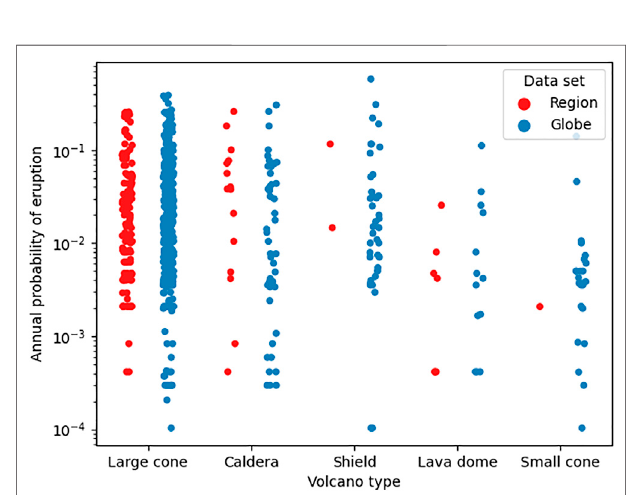
FIGURE 12 | Comparison of dispersion within the A1 volcano classi fi cation system when using a global dataset compared to a regionally constrained dataset. Few underlying data at the regional level for shield, lava dome, and small cone makes developing analogue sets with robust statistical relationships